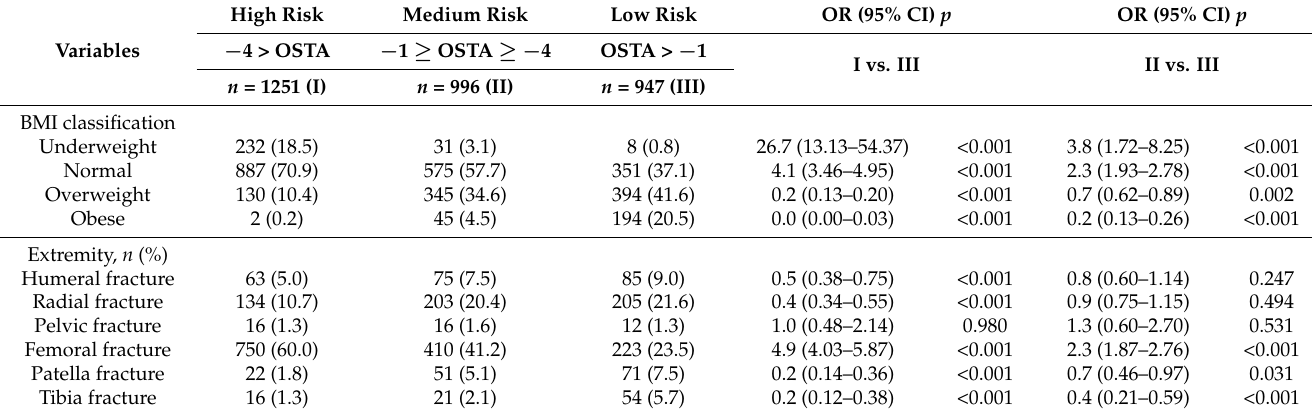
Table 6. Associated extremity fractures in high-risk (OSTA < − 4), medium-risk ( − 1 ≥ OSTA ≥ − 4), and low-risk (OSTA > − 1) patients in fall